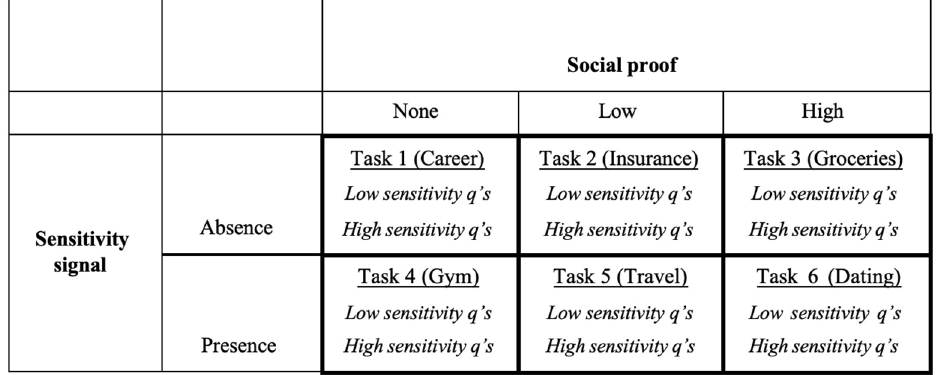
Figure 2. Experimental Design.